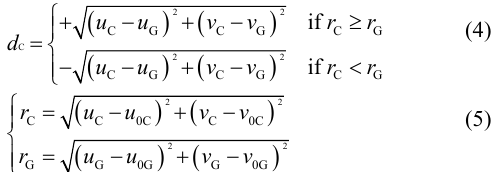
Figure 2 using two sets of compression parameters for the modes Fine and Normal of EOS 20D. The compression ratio in the study was defined as the ratio of the raw data size in bytes of an uncompressed image to the file size in bytes of a compressed image data. The compression ratios for an ordinary color image of the modes Fine and Normal with 2x1 1x1 1x1 sampling of EOS 20D are expected to be 6.5 and 13.0 respectively.